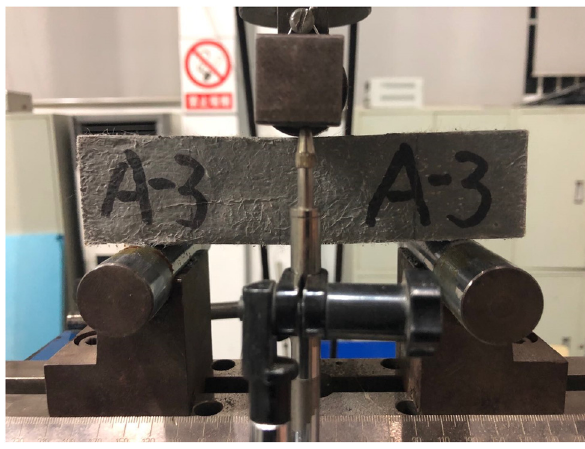
Figure 3: Three - point bending testing set - up. Figure 4: Uniaxial tensile testing set - up and specimen with